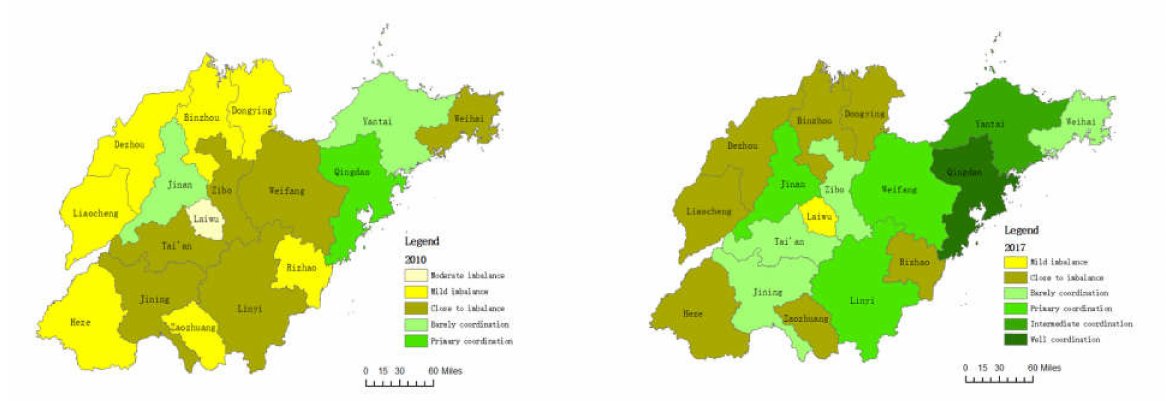
Figure 5. Coupling coordinative type of TEE of Shangdong Province in 2010 and